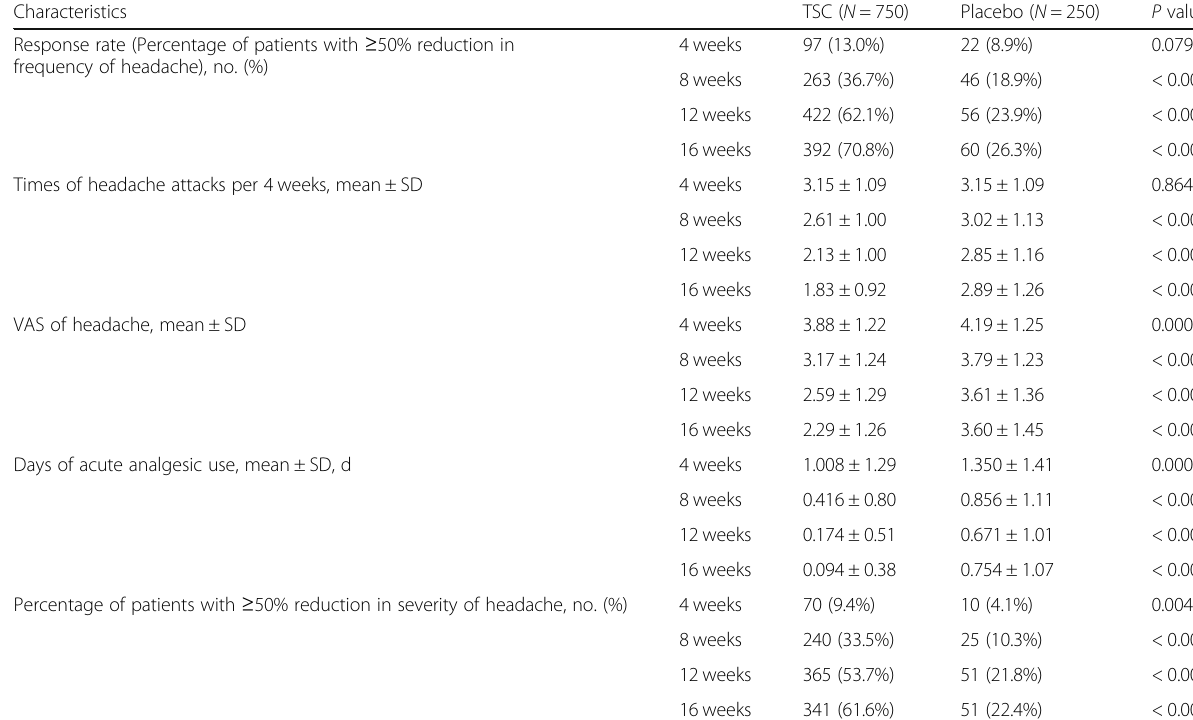
Table 4 Change in efficacy measurements between TSC and placebo groups in the full analysis set (FAS)